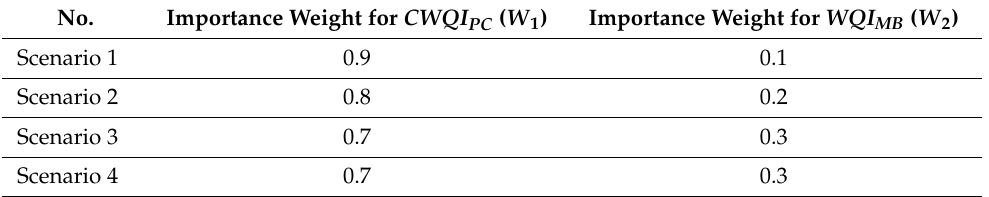
Table 5. Weighting scheme for